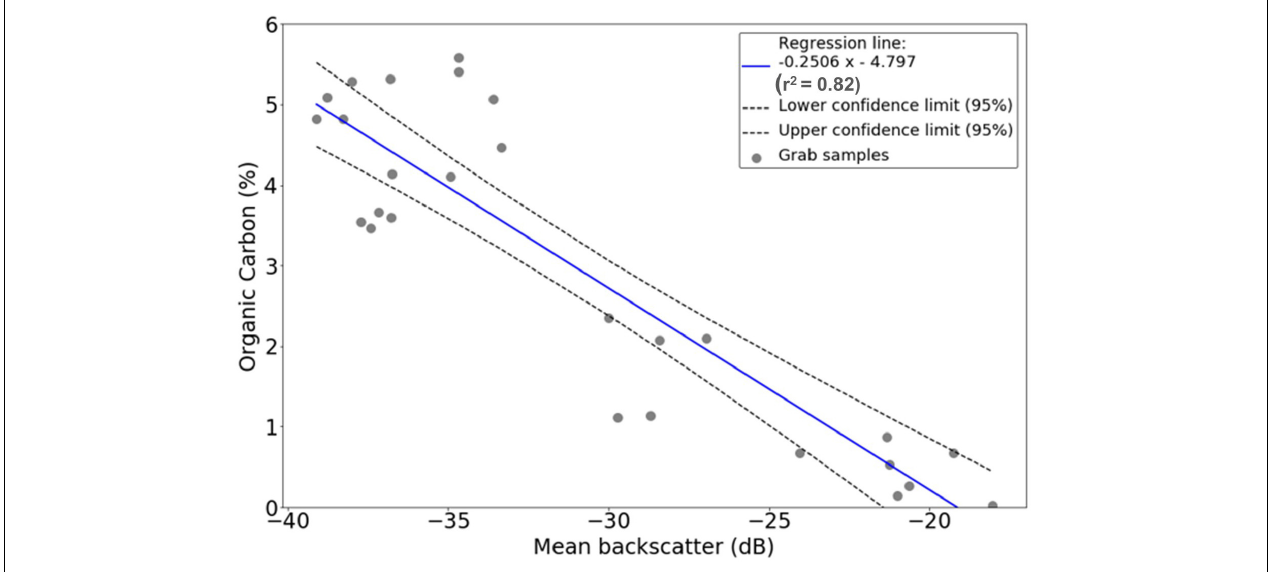
FIGURE 9 | Results of linear regression correlating mean backscatter with OC for each grab sample from Loch Creran; 95% confidence intervals are